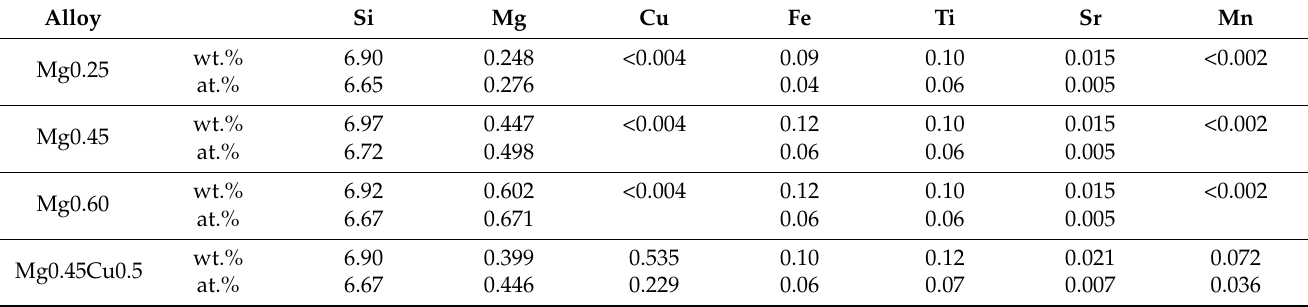
Table 1. Chemical composition of the four alloys used in this study, by weight and atomic fractions, measured with optical emission spectroscopy